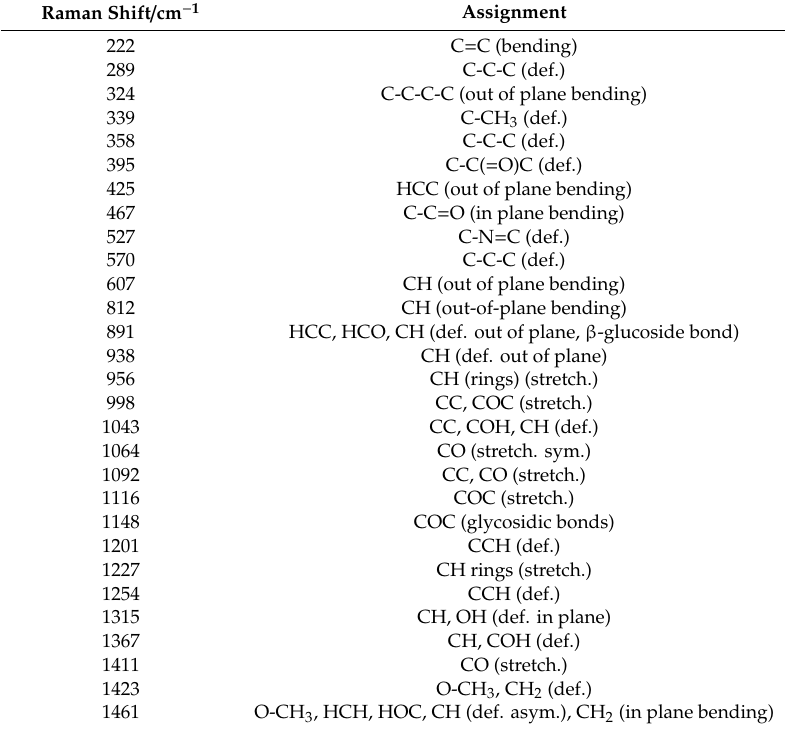
Figure 4. The relative intensity of Raman spectra of 1,3- β - d -glucan ( A ) and spectra normalized to the band at 1092 cm − 1 ( B ). Table 2. The most important bands obtained in the Raman spectra of 1,3- β - d -glucan [6,36].